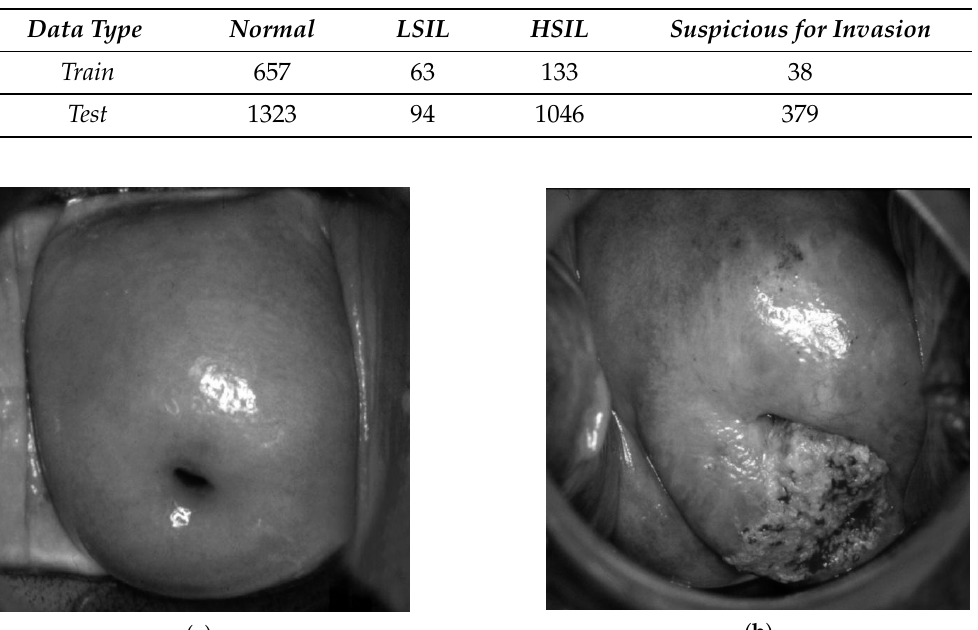
Table 1. Description of the dataset.